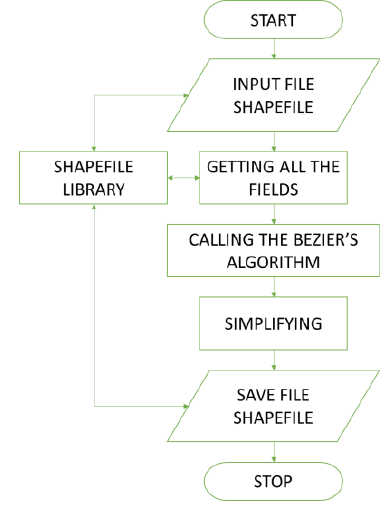
Figure 5: Flowchart of the Beizer’s